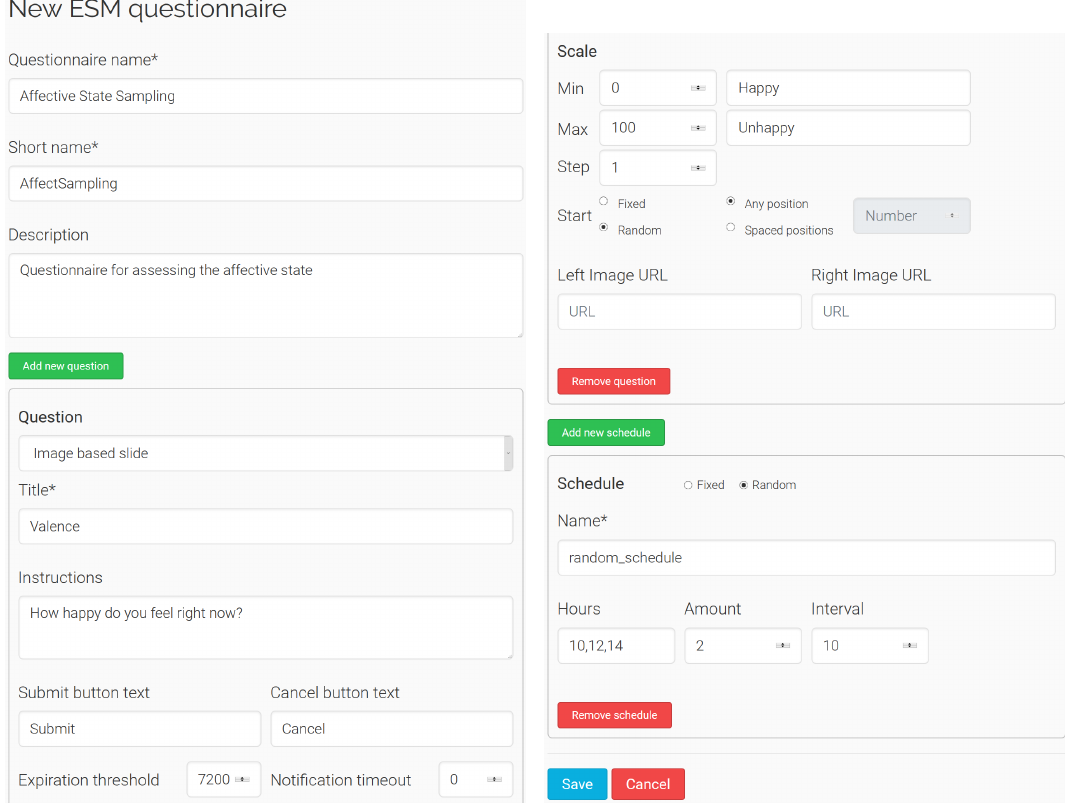
Figure 5. ESM Management